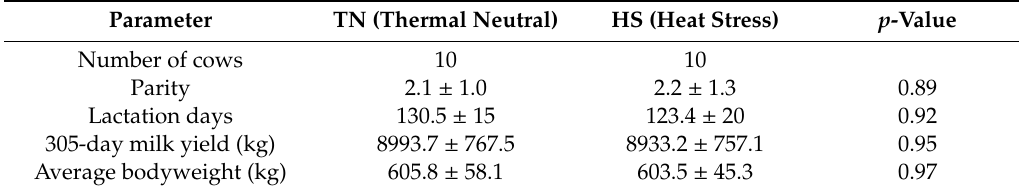
Table 1. Characteristics of the experimental cows.